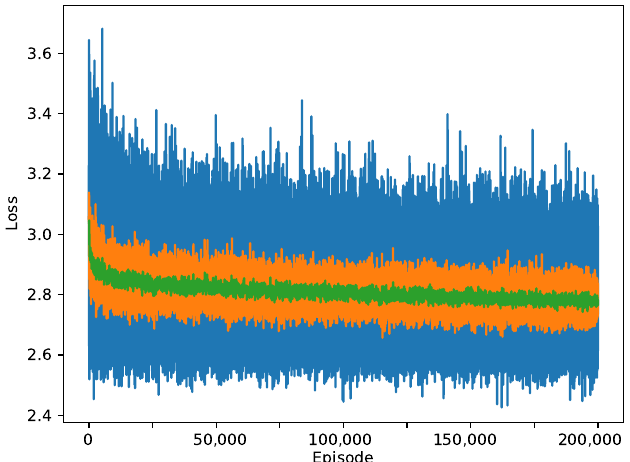
Figure 12. The loss function value in training the AtomicNet using 2-bit ADC. The blue line is the value of the loss function at each episode, the yellow line is the smoothed value with 20 episodes, and the green one is the smoothed value with 100 episodes.